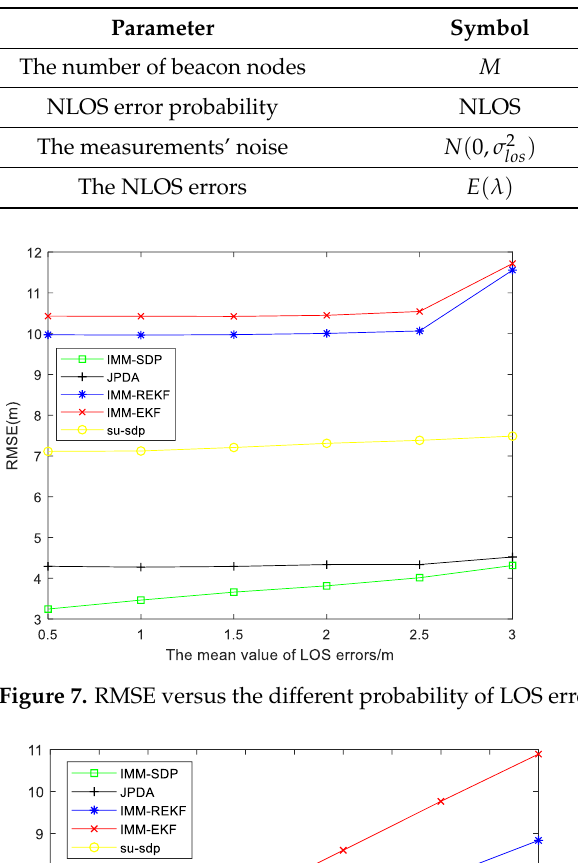
Table 2. Exponential distribution parameter diagram .